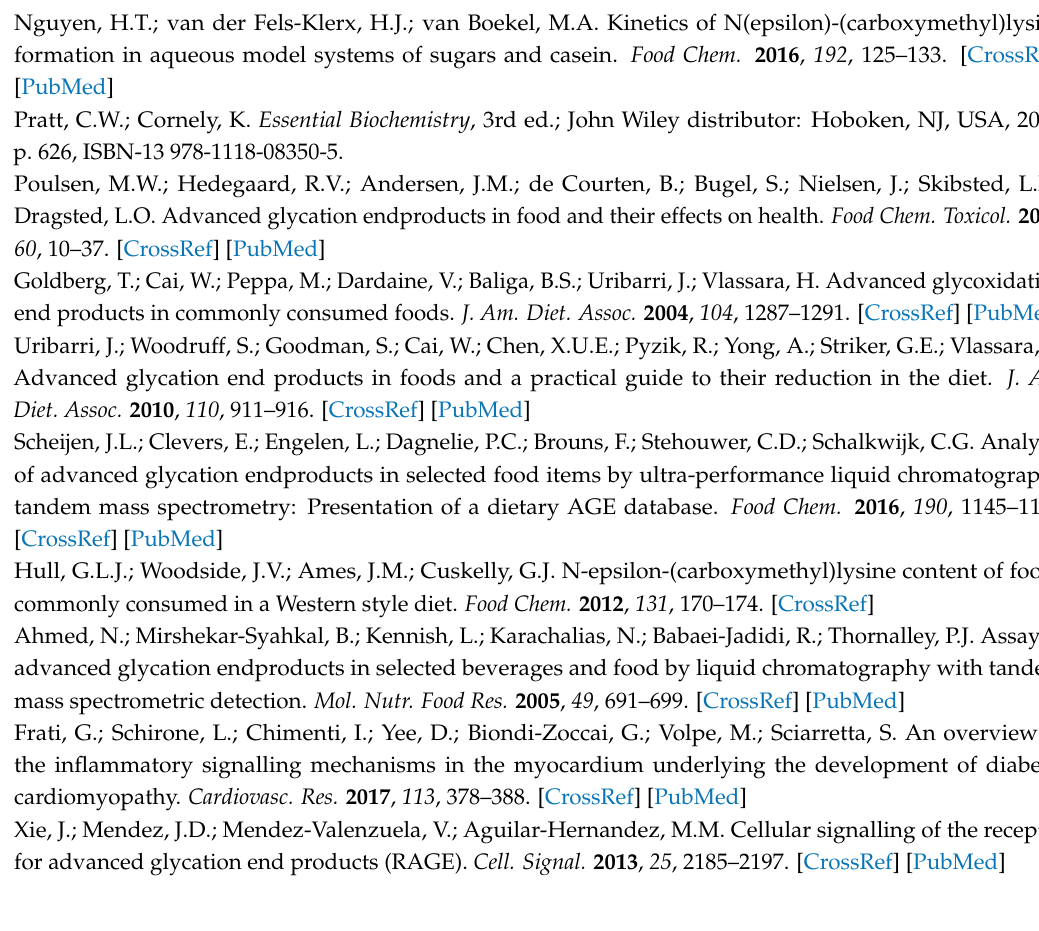
s1, Table S1: Target compounds and selected instrumental parameters for quantification of each compound by UPLC-(ESI+) MS/MS. Table S2: Instrumental detection and quantitation limits and method detection and quantitation limits at